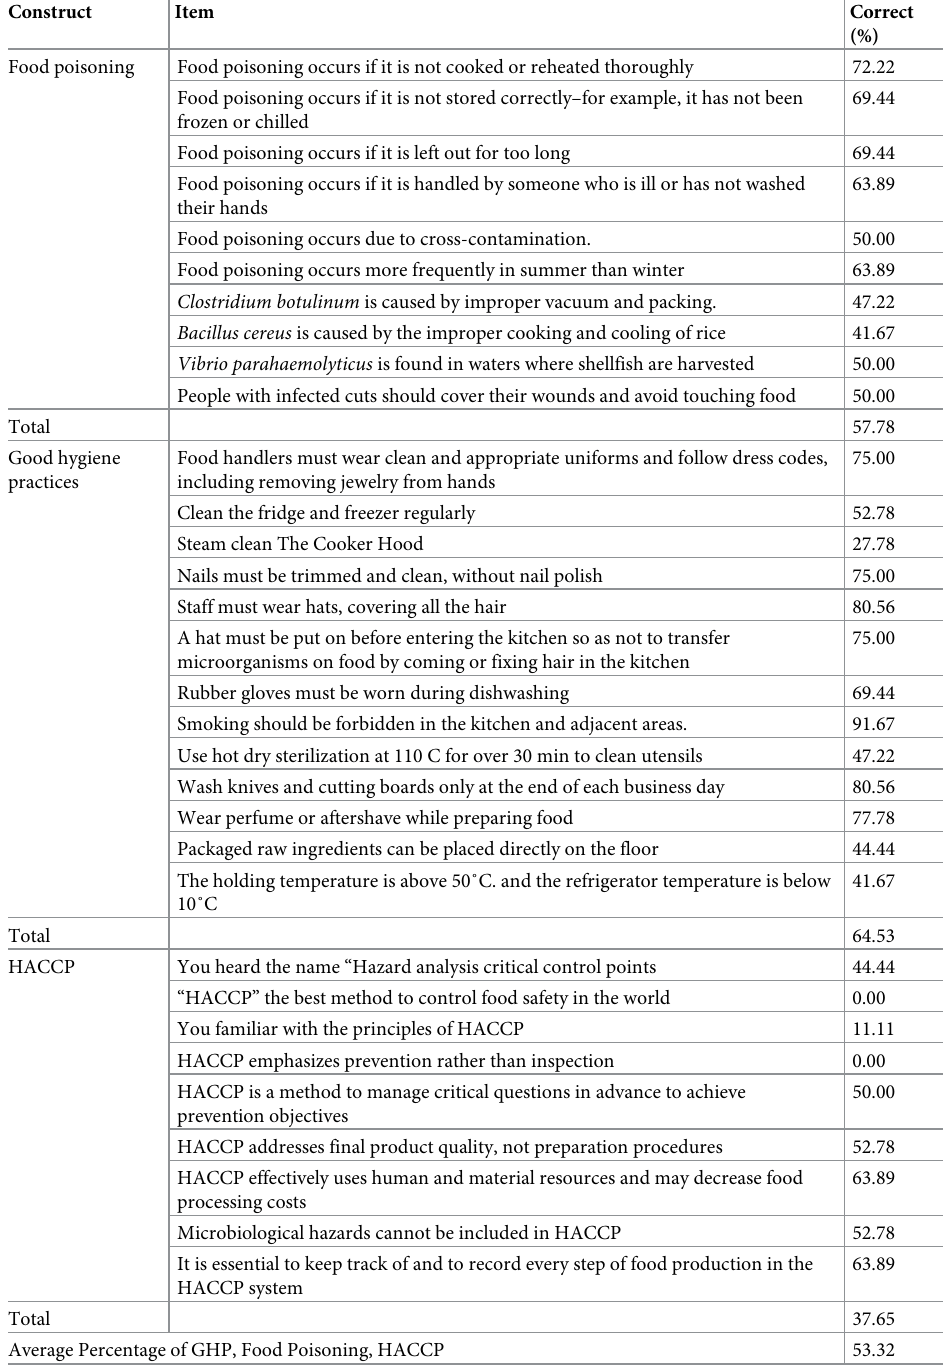
Table 2. Percentage of correct responses on food safety knowledge (N =